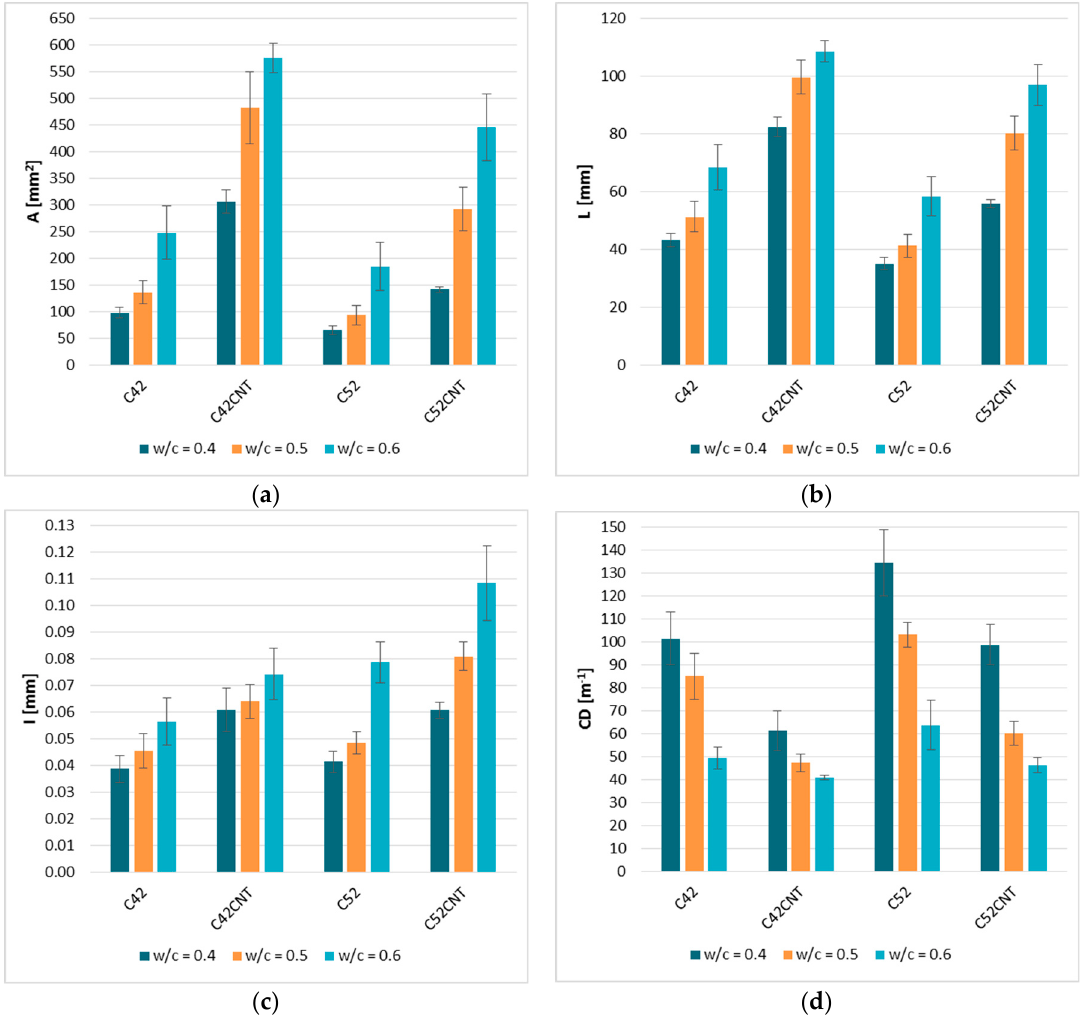
Figure 6. The results of the quantitative characteristics of the cracking patterns: ( a ) A —the cluster average area; ( b ) L —the cluster average perimeter; ( c ) I —the average crack width; ( d ) CD —the crack density. Error bars represent the standard deviations.